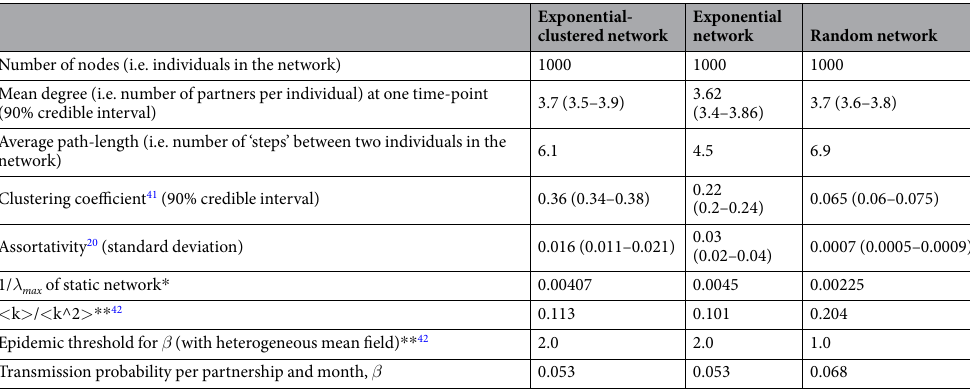
Table 1. Comparison between the skewed-clustered-assortative network and random network ( * λ max being the largest eigenvalue of the adjacency matrix, ** < k > the